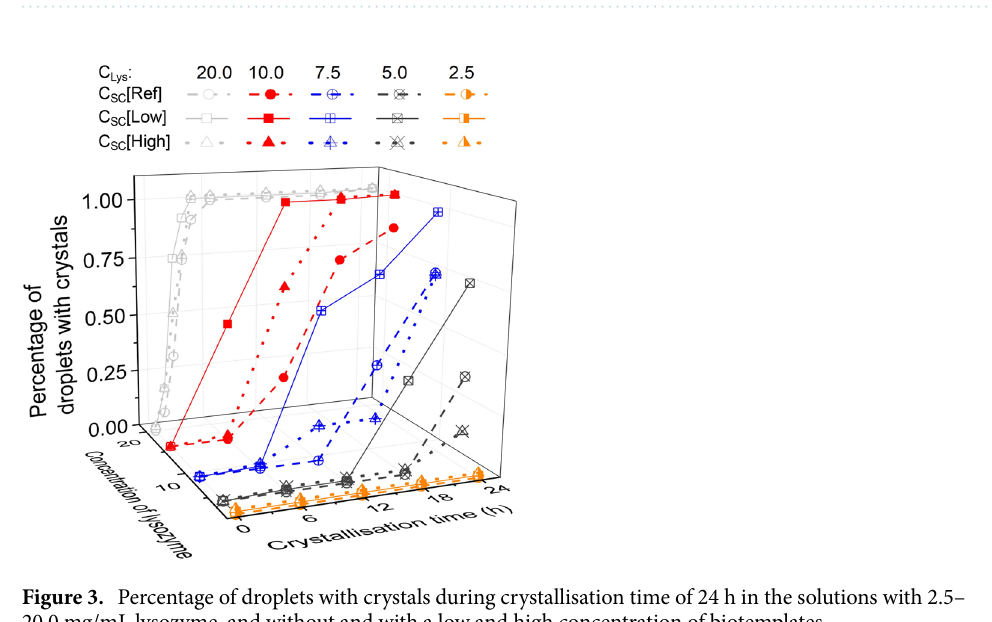
Figure 2. Percentage of droplets with crystals during crystallisation time of 96 h in the solution of 2.5–20.0 mg/ mL lysozyme and without biotemplates ( a ), with a low concentration of biotemplates ( b ) and high concentration of biotemplates ( c ).